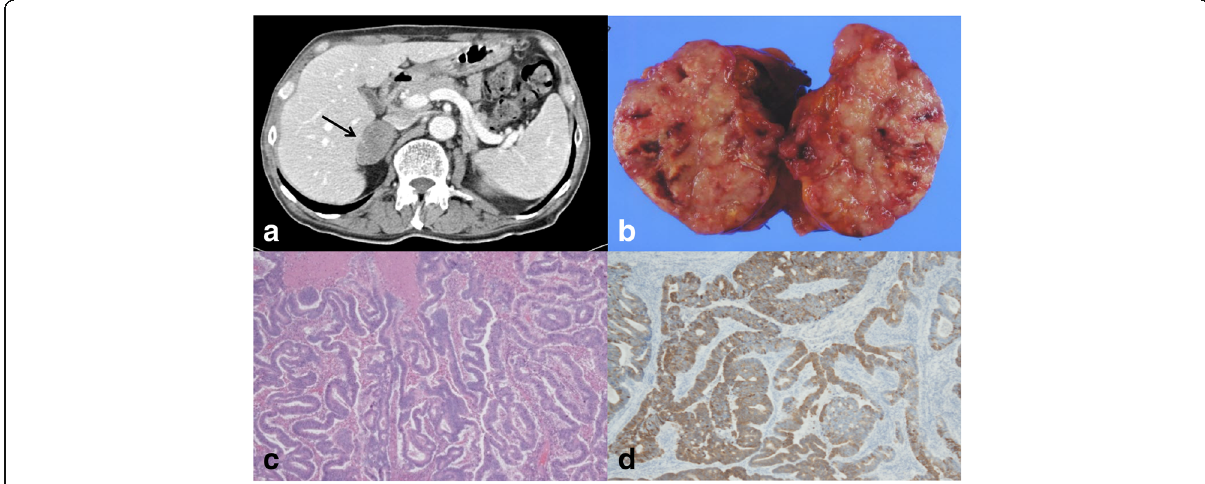
Fig. 1 The clinicopathological findings in Case 1. a The preoperative findings: Abdominal CT showed a right adrenal tumor 4.7 cm in size (black arrow). b The macroscopic appearance: A cross-section of the adrenal tumor was solid and grayish white. c The histopathological findings: The histopathological examination of the adrenal tumor showed adenocarcinoma, which was compatible with metastasis of primary rectal cancer. d The immunohistochemical findings (CK20 staining): Adrenal tumor cells were positive for cytokeratin20 and negative for